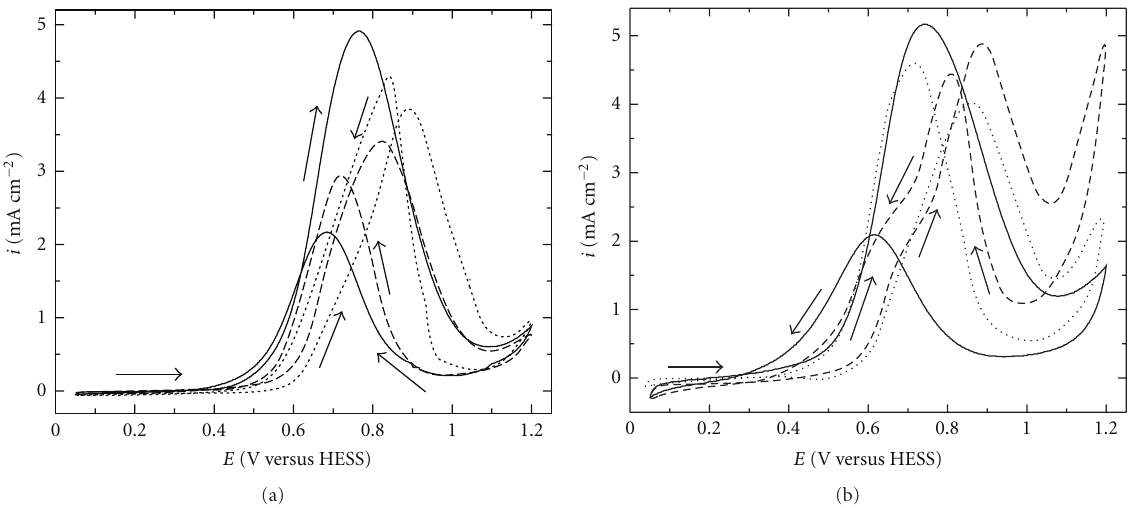
Figure 10: Cyclic voltammetric study (second cycle) for electrochemistry oxidation of 0.5 M of (a) methanol and (b) ethanol. Dotted line correspond to Pt/BDD, dashed line Pt-RuO 2 /BDD, and solid line Pt-RuO 2 -RhO 2 /BDD electrodes materials ( ν = 0 . 005 Vs − 1 ) (reprinted with permission from